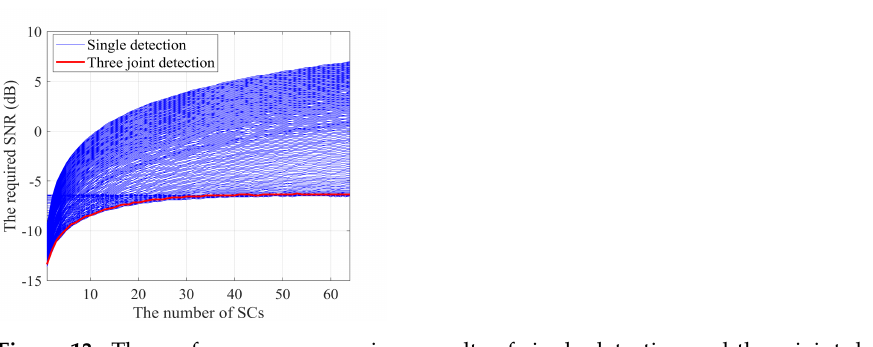
Figure 13. The performance comparison results of single detection and three joint detections of